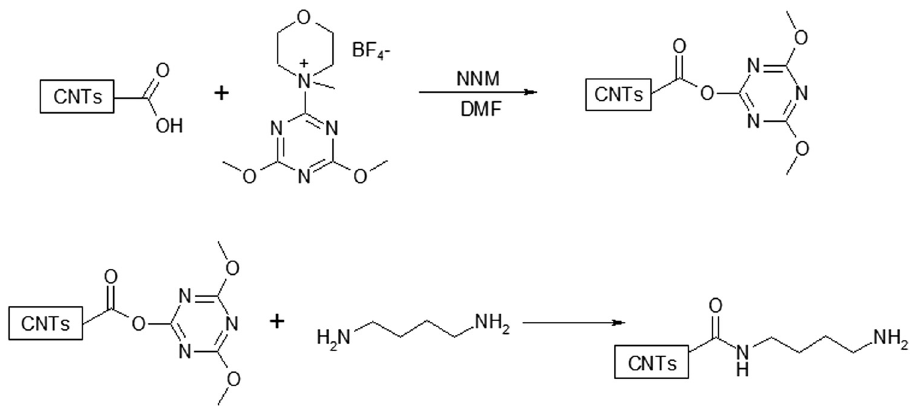
Figure 3: Synthesis of CNTs modi fi ed with 1,4 - diaminobutane via amide